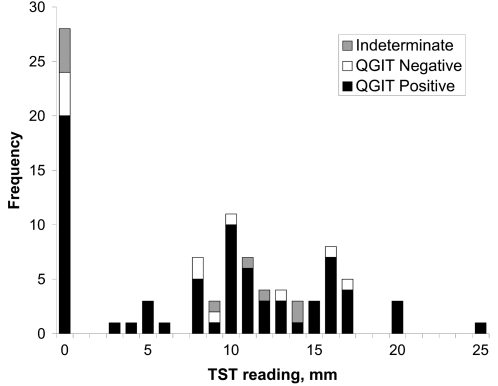
Frequency plot of tuberculin skin test readings showing QuantiFERON-TB® Gold In-Tube result.Concordance between TST and QGIT was poor with negative and indeterminate QGIT results occurring throughout the range of TST results. TST, tuberculin skin test; QGIT, QuantiFERON-TB® Gold In-Tube.